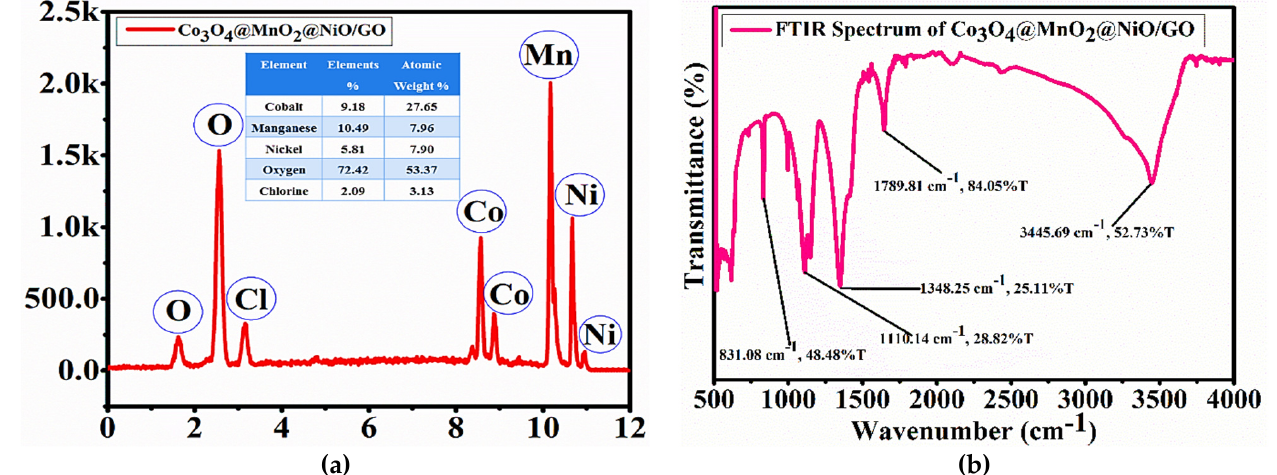
Figure 5. ( a ) EDS and ( b ) FTIR Spectra of Pristine Co 3 O 4 @MnO 2 @NiO/GO Electrode .